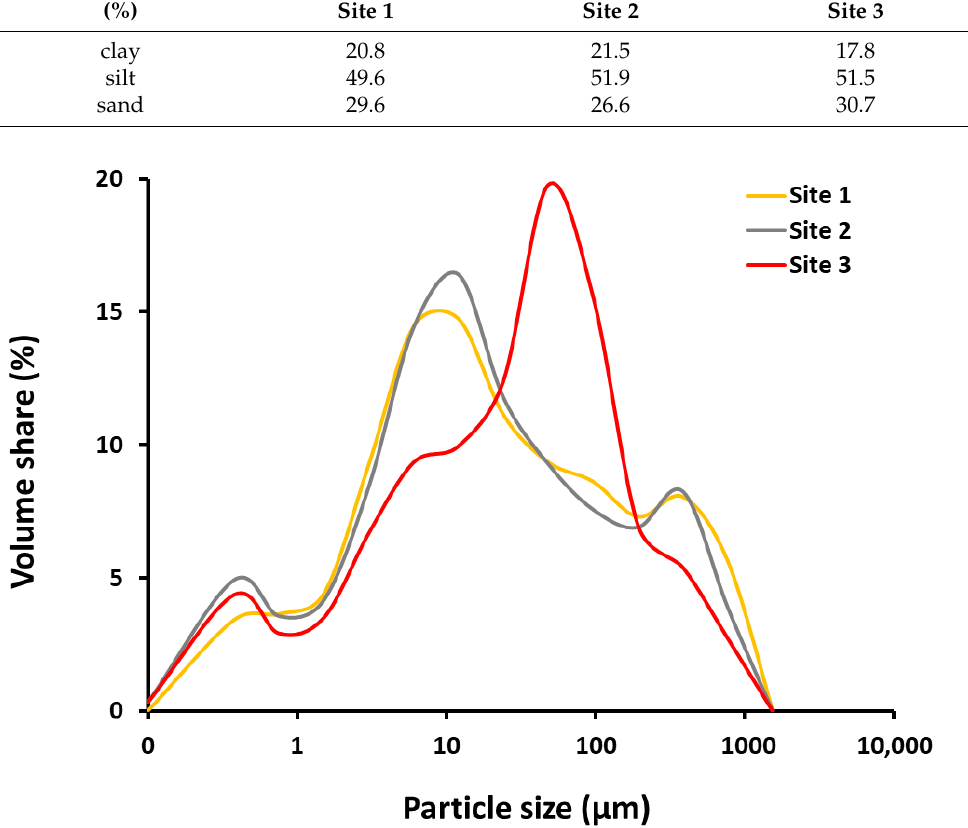
Figure 1. Grain size distribution in studied sediments.